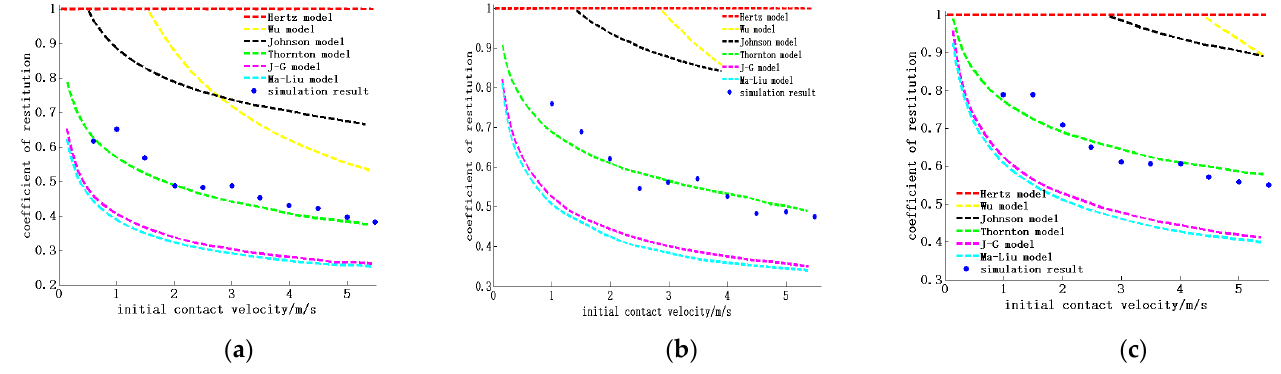
Figure 4. Influence of the yield strength of the ball on the coefficient of restitution: ( a ) yield strength of 400 MPa, ( b ) yield strength of 600 MPa, ( c ) yield strength of 800 MPa.